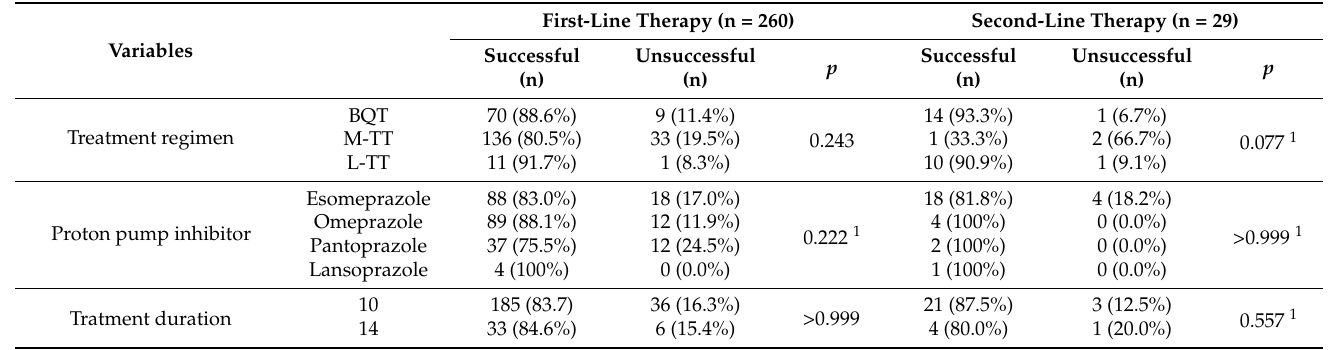
Table 3. Comparison of the treatment effectiveness depending on the treatment type, IPP, and treatment duration with a split into first- and second-line